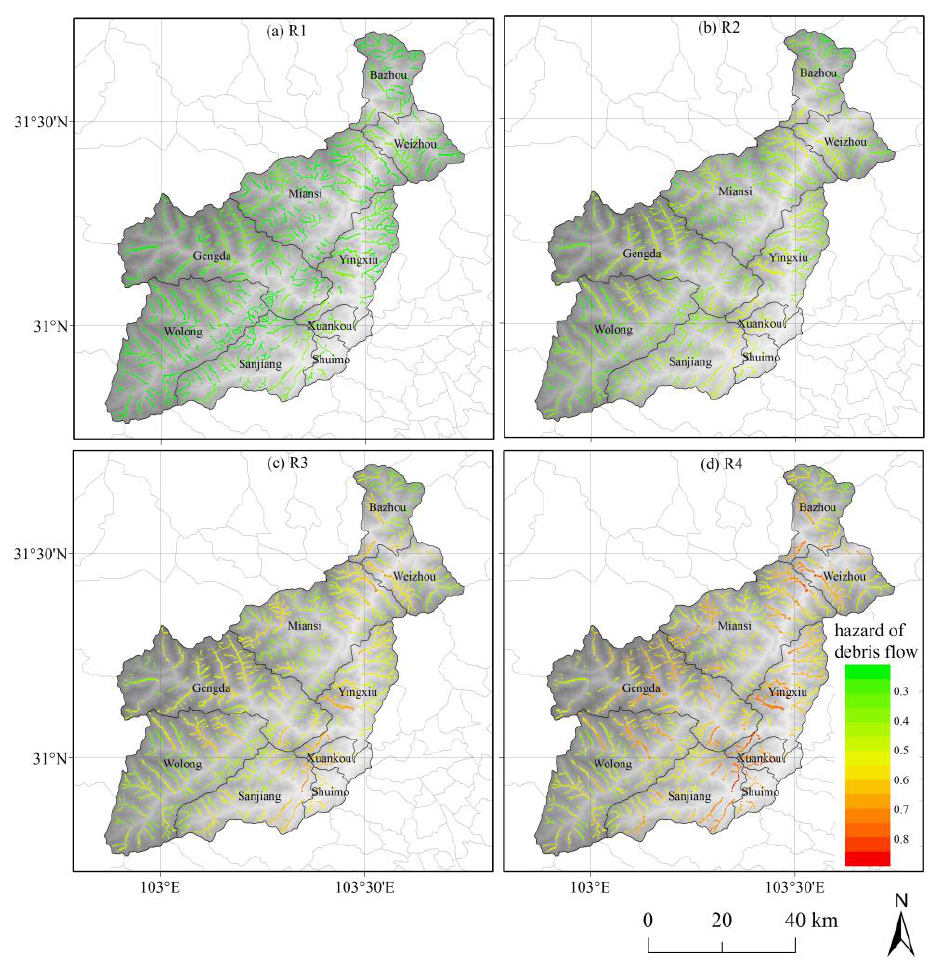
Figure 4. Spatial analysis of the debris flow hazards under rainstorm scenarios. From the perspective of the distribution of the debris flow hazard at the township scale (Figure 5), it is relatively high in Xuankou (0.32, 0.47, 0.62, and 0.74 under scenarios RS1, RS2, RS3, and RS4, respectively) where there are fewer hazard areas. It is 0.22, 0.34, 0.44, and 0.52 in Wolong, which has the largest hazard area. As the intensity of the heavy rain increases, the hazard increases significantly, but the growth rate decreases. The debris flow hazard under scenario RS2 in the township increases by 0.11–0.15, and the growth rate is 47.65–51.00% compared with scenario RS1. The hazard under scenario RS4 increases by 0.07–0.12, and the growth rate is 15.72–19.26% compared with scenario RS3. From the perspective of the hazard anomaly percentage of each township, Xuankou, Shuimo, and Yingxiu are significantly higher than the regional average; Gengda, Sanjiang, and Weizhou are slightly higher; Bazhou and Wolong are